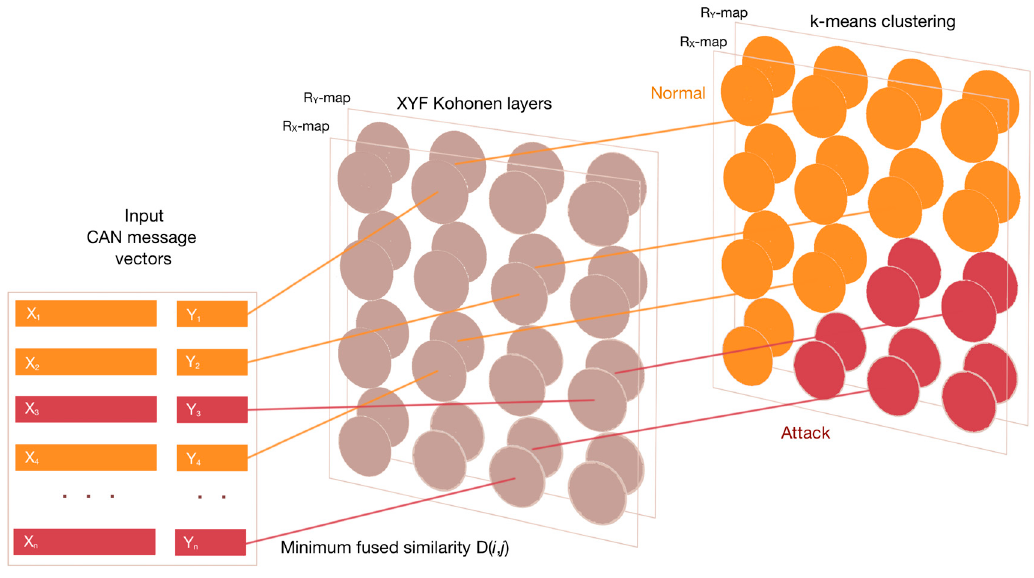
Figure 2. The XYF–K Figure 2. The XYF – K algorithm.